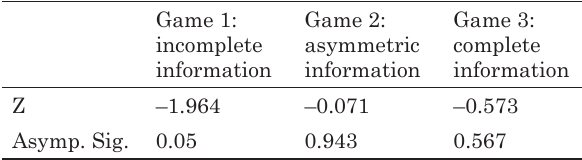
Table 5. Wilcoxon signed-rank test results